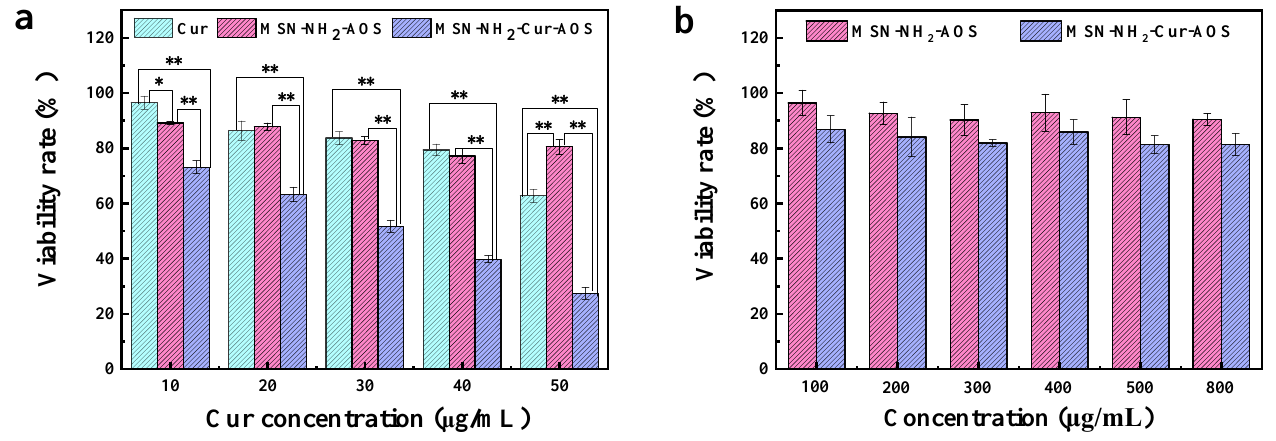
Figure 10. HCT-116 cell viability rates following 24 h treatment with Cur, MSN-NH 2 -AOS (mass of MSN-NH 2 -AOS carrier containing the same amount of Cur), and MSN-NH 2 -Cur-AOS nanoparticles (* p < 0.05; ** p < 0.01) ( a ). Viability rates of L929 cells treated with different concentrations of MSN-NH 2 -AOS and MSN-NH 2 -Cur-AOS ( b ).